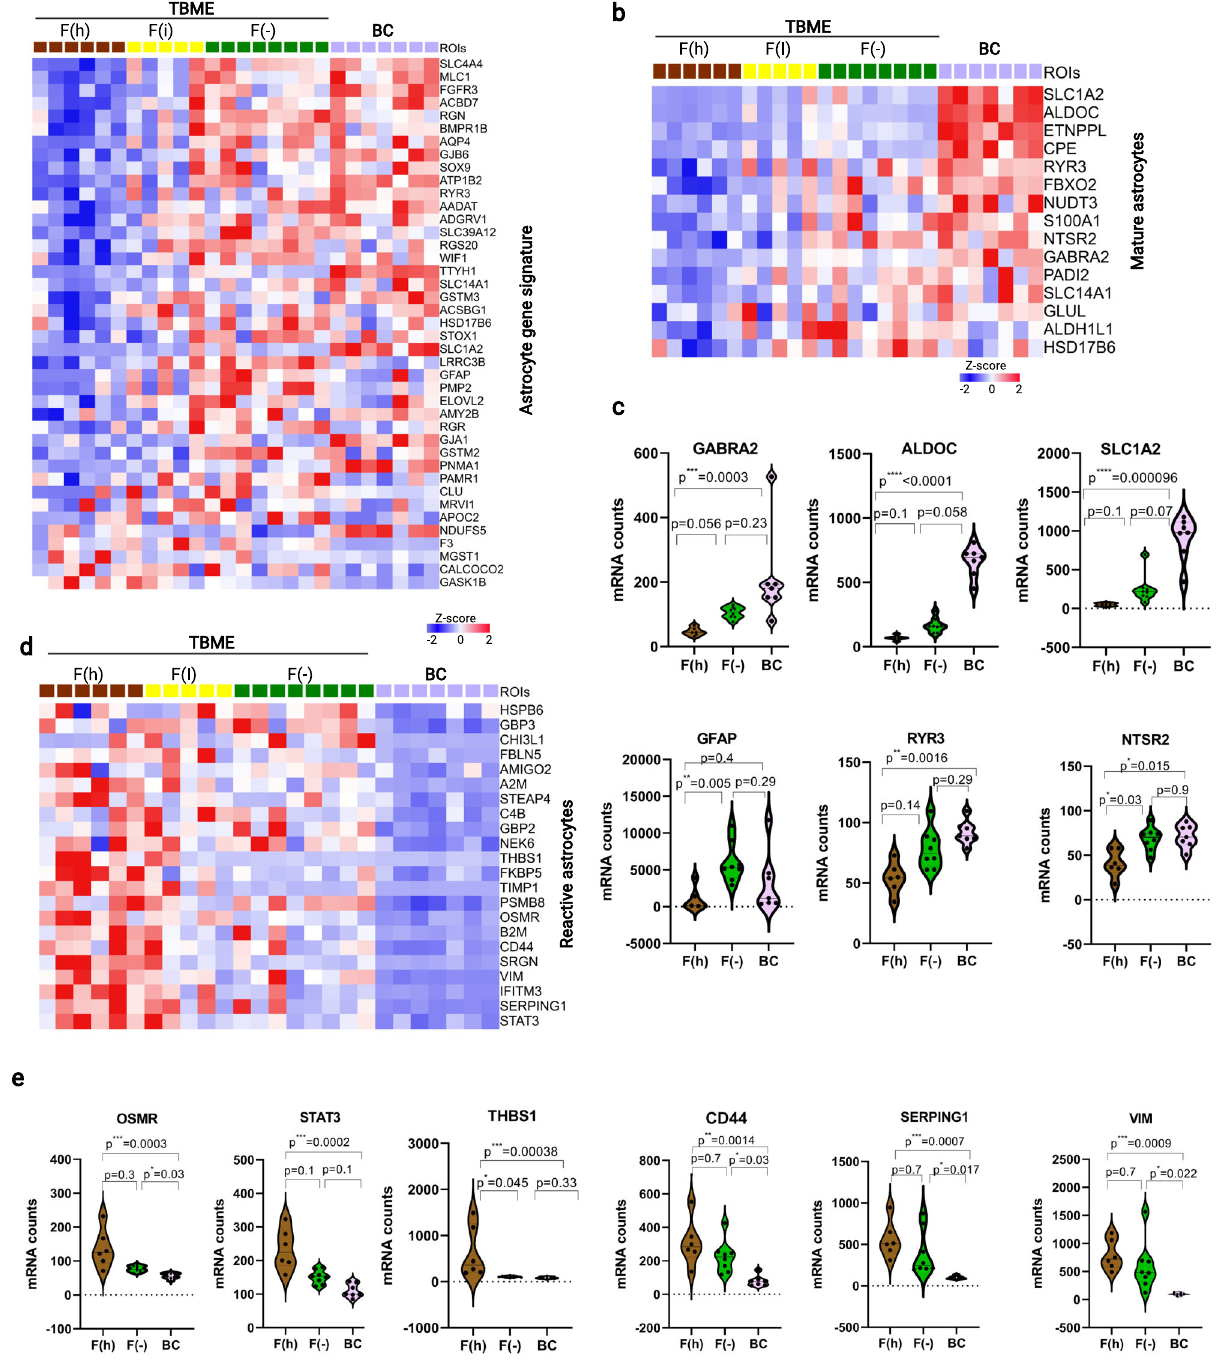
Fig. 6 | Reprogramming of astrocytes in the TBME. a Heatmap of differential expression of astrocyte signature genes in the TBME and BC ROIs. P <0.05, Stu- dent ’ s t test (two-sided). b Mature astrocyte markers were signi fi cantly down- regulatedinthe TBME. P <0.05,Student ’ s t test (two-sided). c Violin plots showing signi fi cantly different expression of a selection of mature astrocyte markers between the fi brotic vs. non fi brotic TBME. The P values were based on nonpara- metric test (Kruskal – Wallis) followed by Dunn test for pairwise comparisons. The dashed and solid lines within the plots indicate upper & lower quartiles and